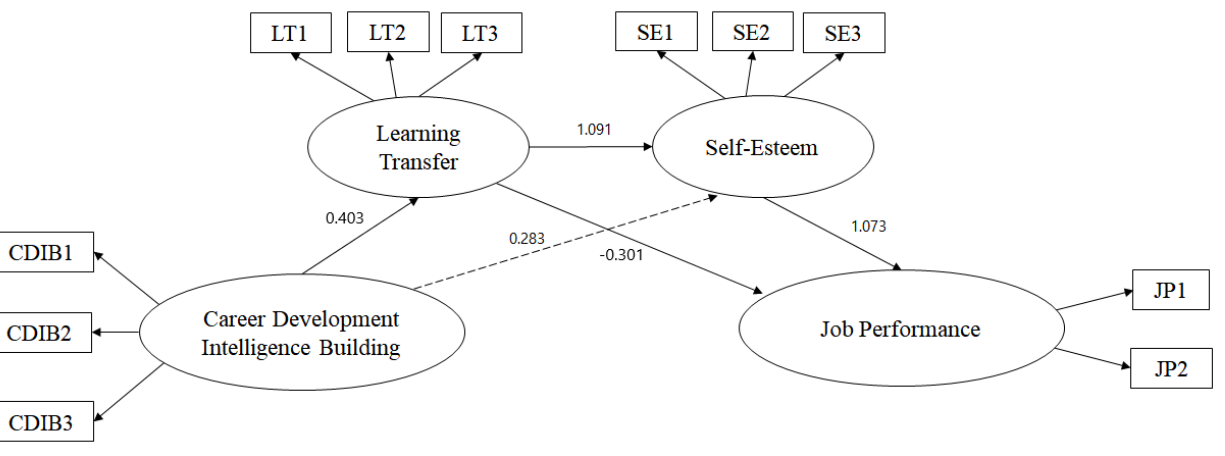
Figure 3. Full mediation model.